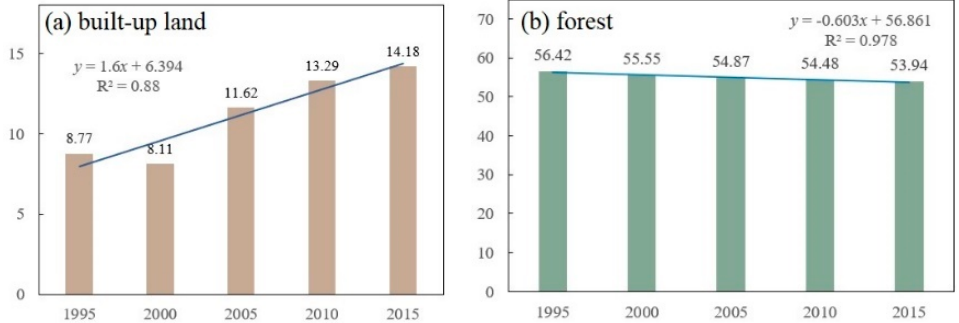
Figure 10. Area of built-up areas and forest land: ( a ) the percentage of built-up land; ( b ) the percentage of forest land.